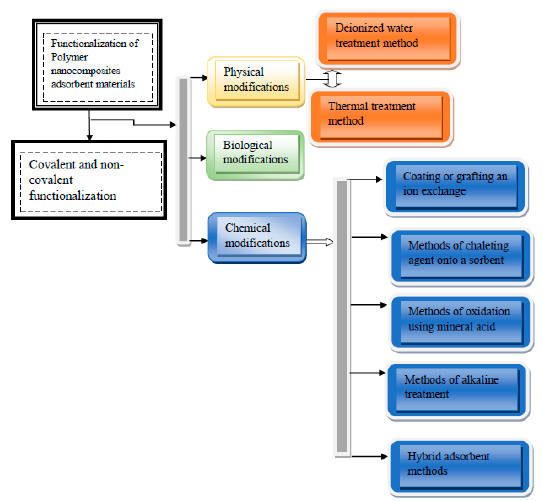
Figure 4. Classes of functionalization (covalent and non-covalent) approaches for